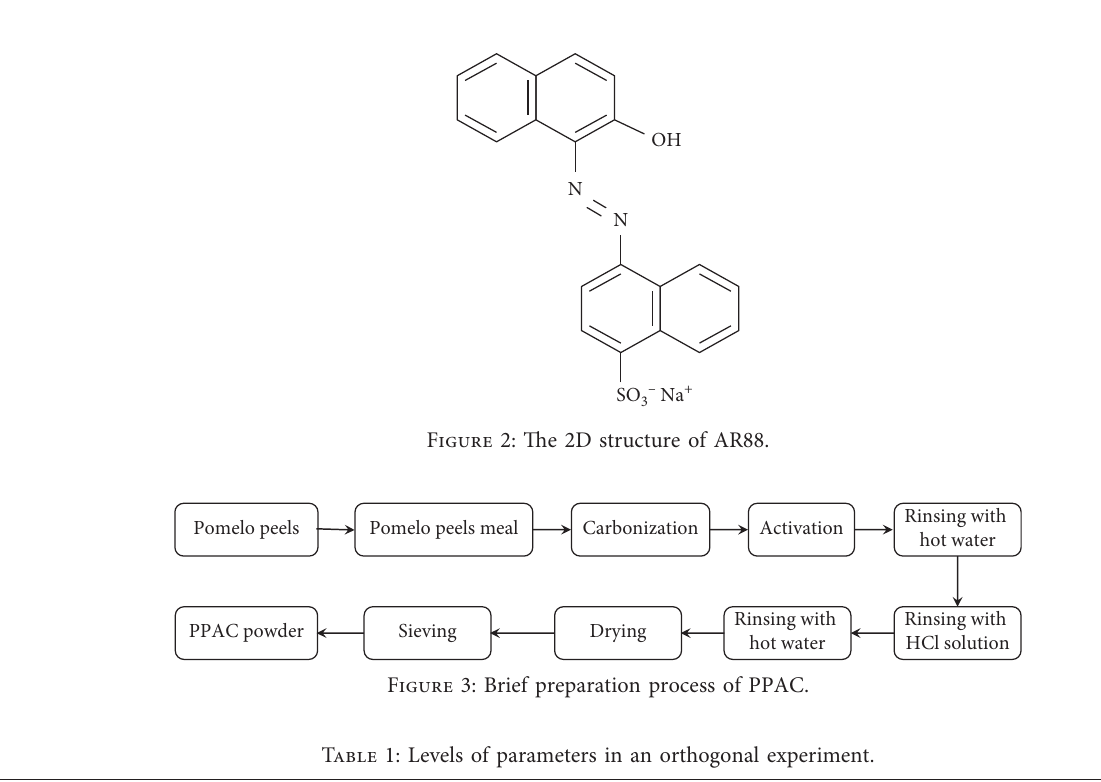
Figure 1: Pomelo peels (a), pomelo peels meal (b), and PPAC